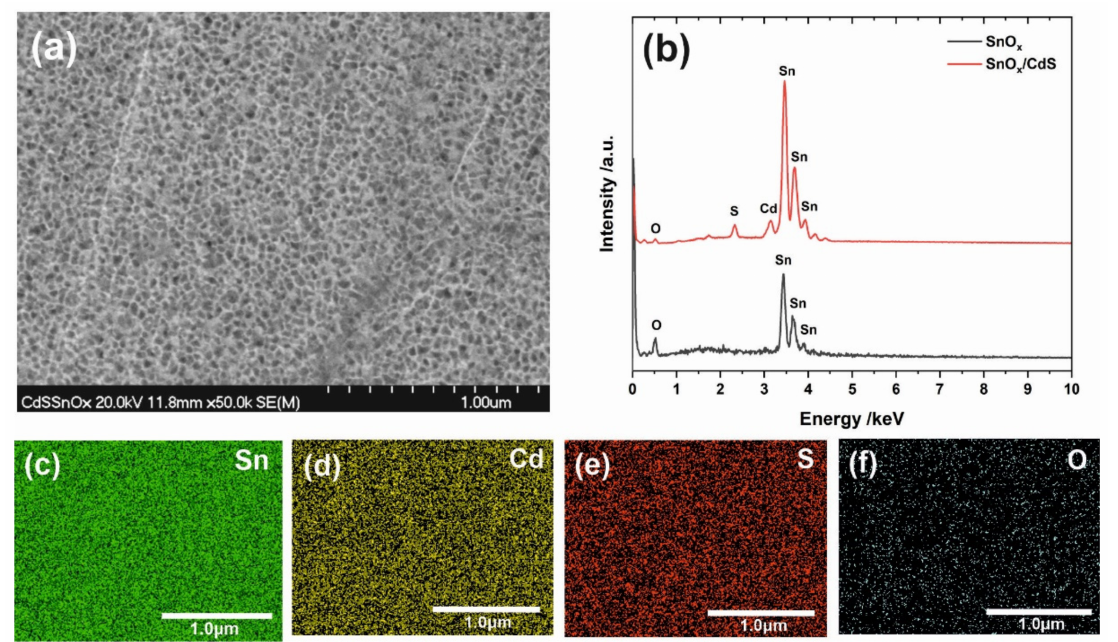
Figure 2. FE-SEM image of annealed nanoporous SnO x /CdS (a) together with EDS elemental mapping of Sn ( c ), Cd ( d ), S ( e ), and O ( f ). ( b ) shows EDS spectra recorded for anodic SnO x (black line) and SnO x /CdS (red